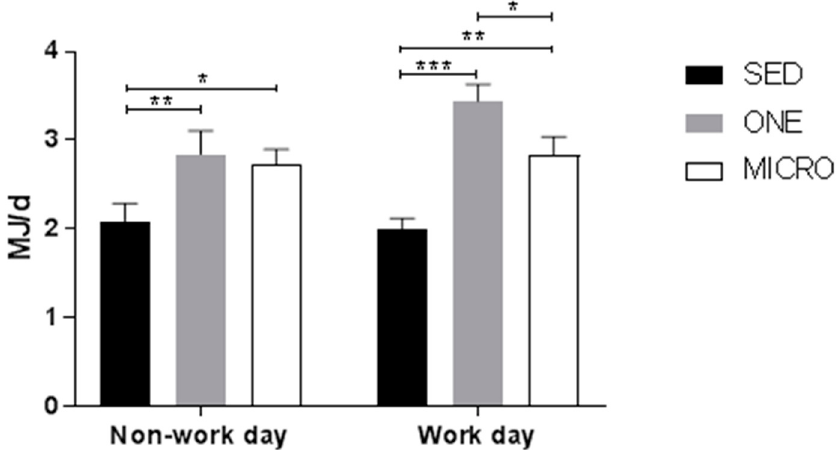
Figure 3. Activity energy expenditure. The activity energy expenditure (MJ/d) estimated from ActiGraph GT3X tri-axial accelerometer is displayed by location (work or non-work day). SED, sedentary condition; ONE, one-bout intervention; MICRO, microbouts intervention. * p < 0.05, ** p < 0.01, *** p < 0.0001 vs. sedentary control condition.